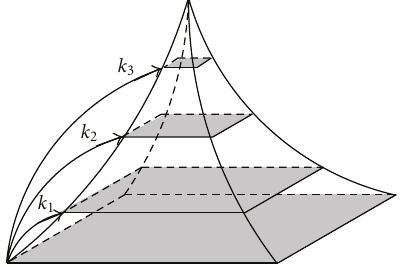
Figure 1: Fast multiscale pyramid representation.